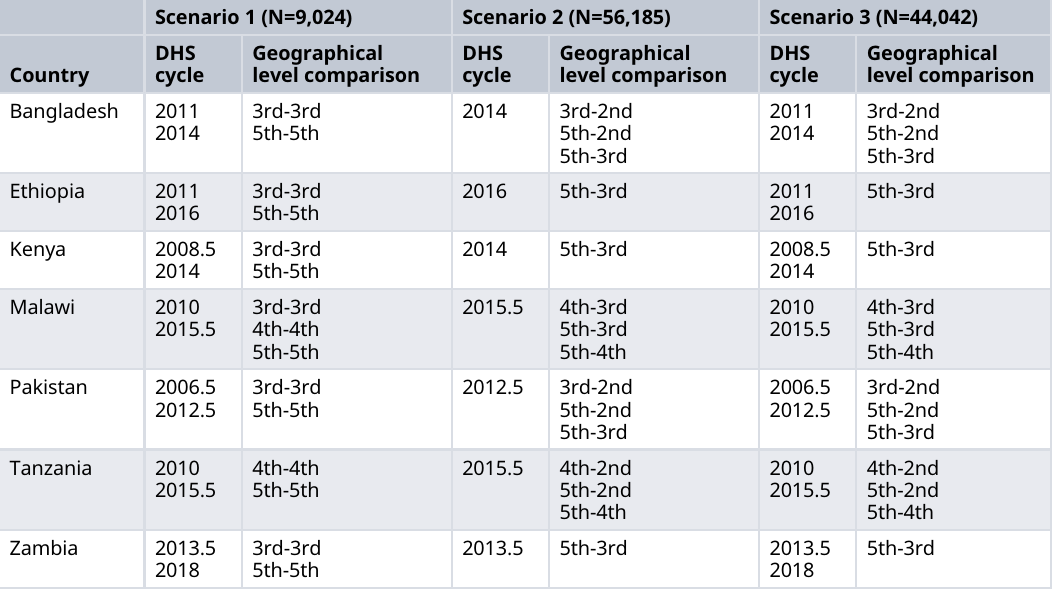
Table 5. Demographic and Health Survey (DHS) cycles and geographical level comparison included in the DHS vs DHS